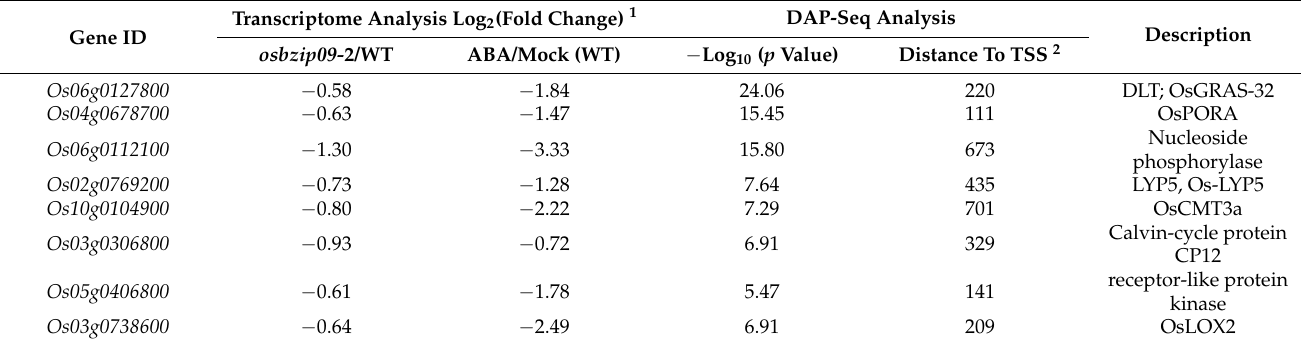
Table 2. List of OsbZIP09 target genes downregulated by ABA and in osbzip09